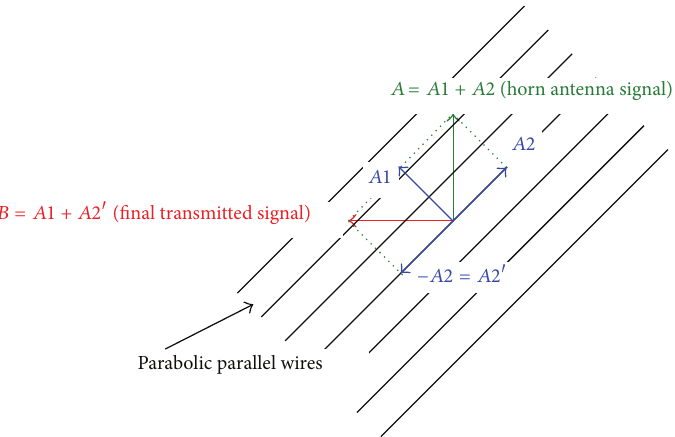
Figure 4: Polarization change of transmitted (received) signal by parabolic main reflector and wires.